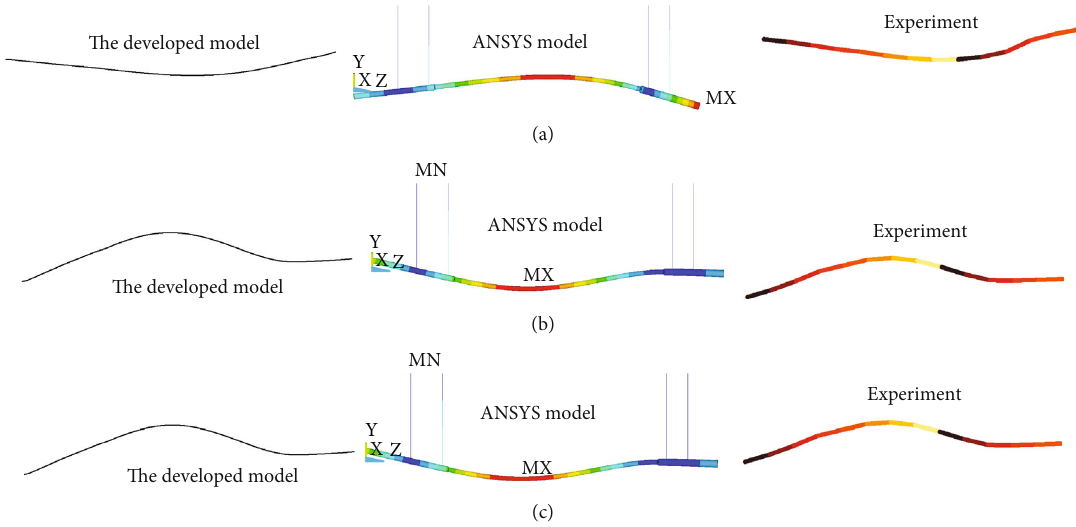
Figure 8: First three model shape of power-turbine rotor: (a) 1st; (b) 2nd; (c) 3rd.